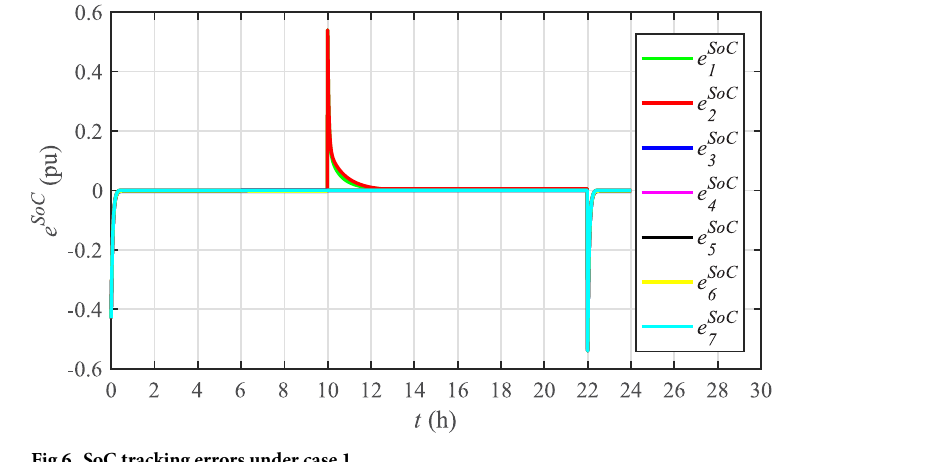
Fig 6. SoC tracking errors under case 1.